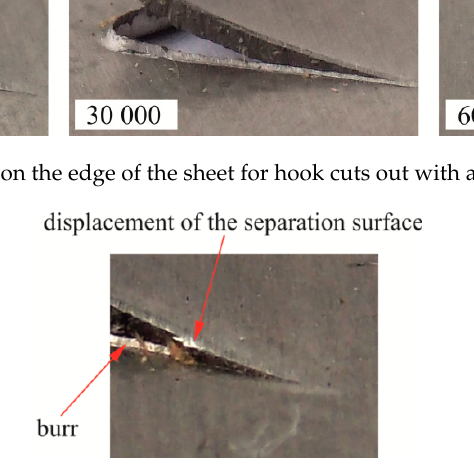
Figure 18. Zoom area (in Figure 17) near the separation of the material of the hook deflection.